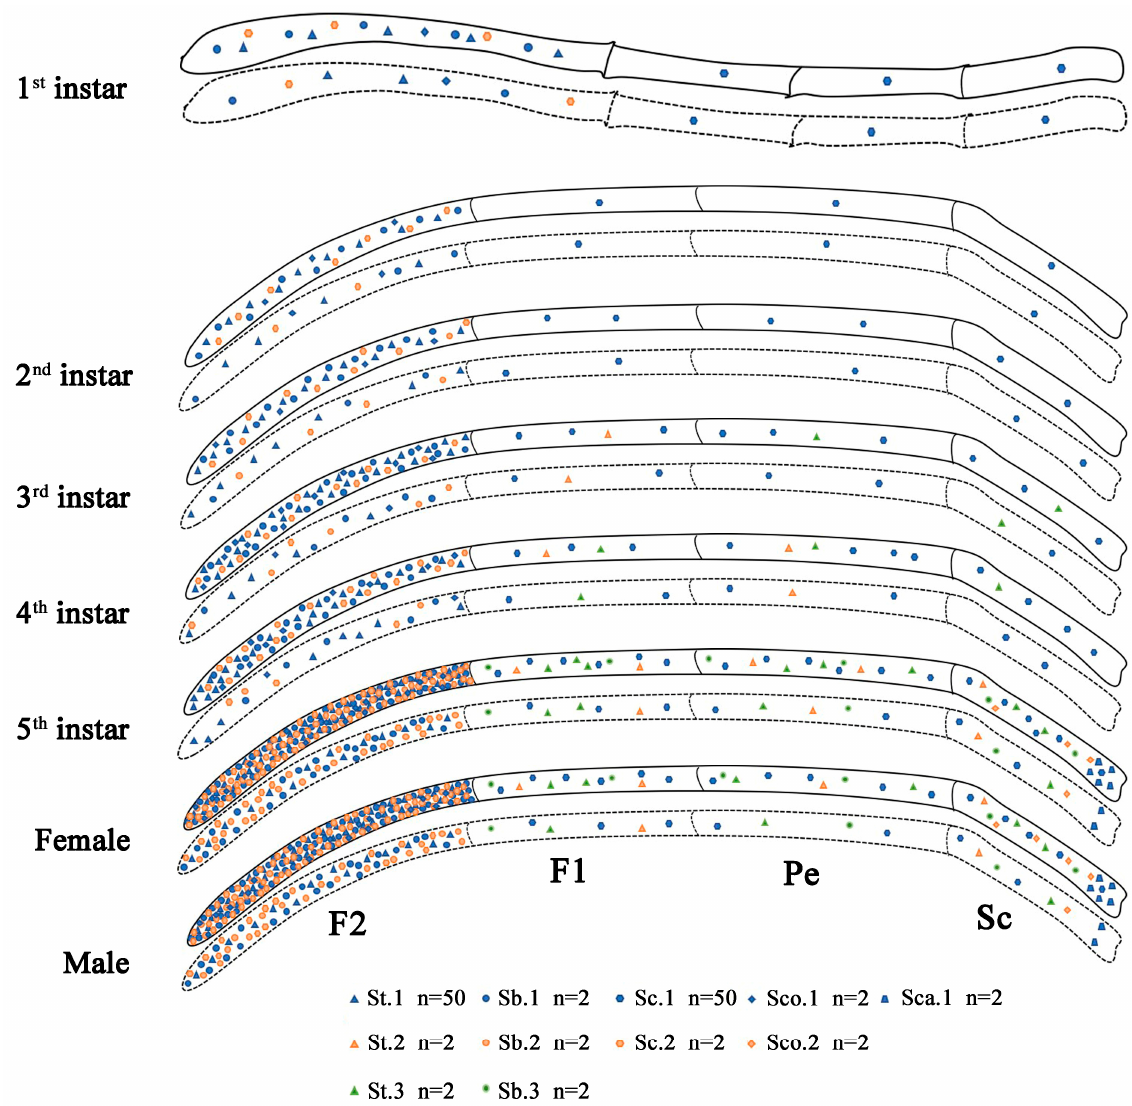
Figure 9. Distribution of antennal sensilla in N. meleagris antennae at each instar. The solid and dotted lines represent the dorsal and ventral sides, respectively.